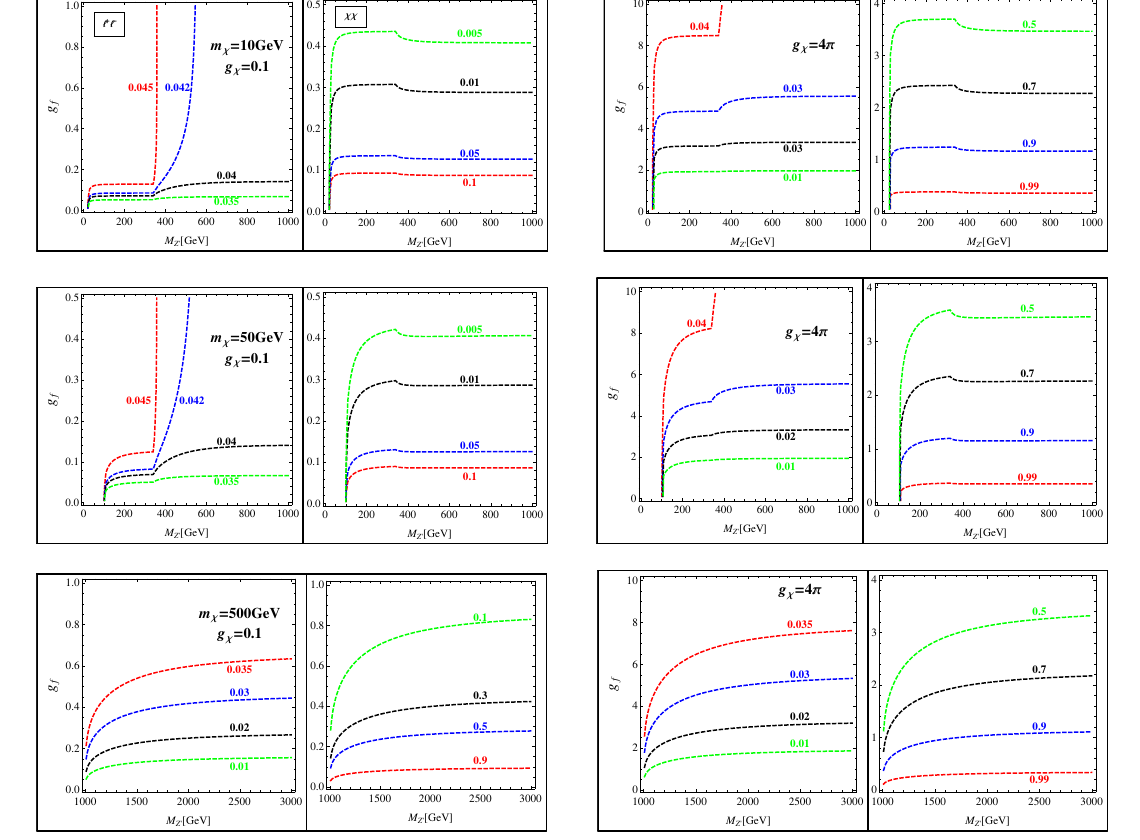
Figure 2 . The branching ratios into leptons (electrons, muons or taus) and DM in the M Z 0 versus g f plane. At each pair of panels, the left one displays the branching to leptons, and the right one to dark matter. In the (cid:12)rst, middle, and last rows we (cid:12)xed m (cid:31) = 10, 50, and 500 GeV, respectively. The left column of plots have g (cid:31) = 0 : 1, while the at right column g (cid:31) = 4 (cid:25) . The dashed lines represent (cid:12)xed branching ratios in the mass-coupling